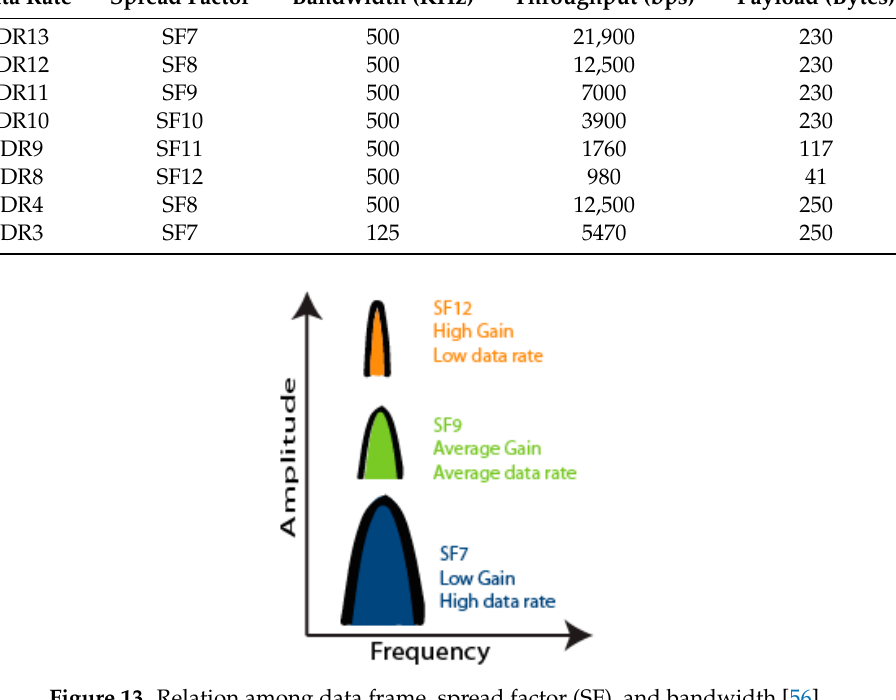
Figure 13. Relation among data frame, spread factor (SF), and bandwidth [56].